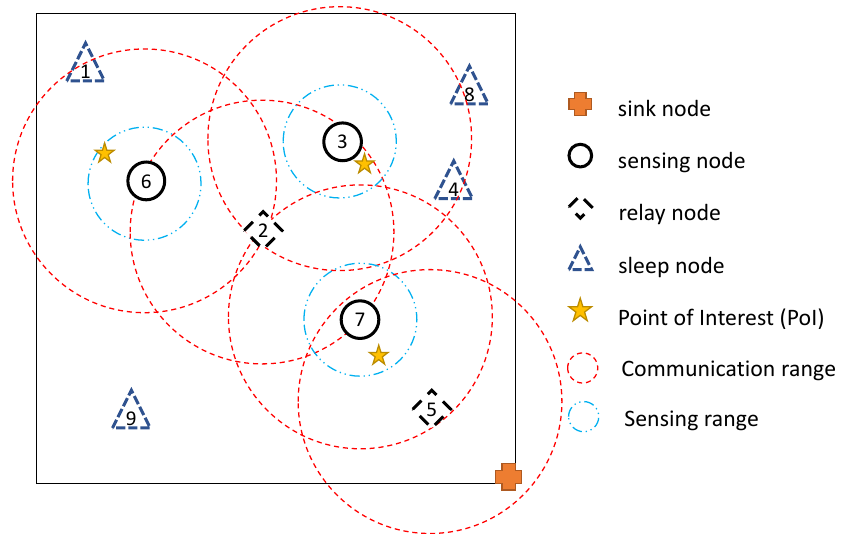
Figure 2. Example of network